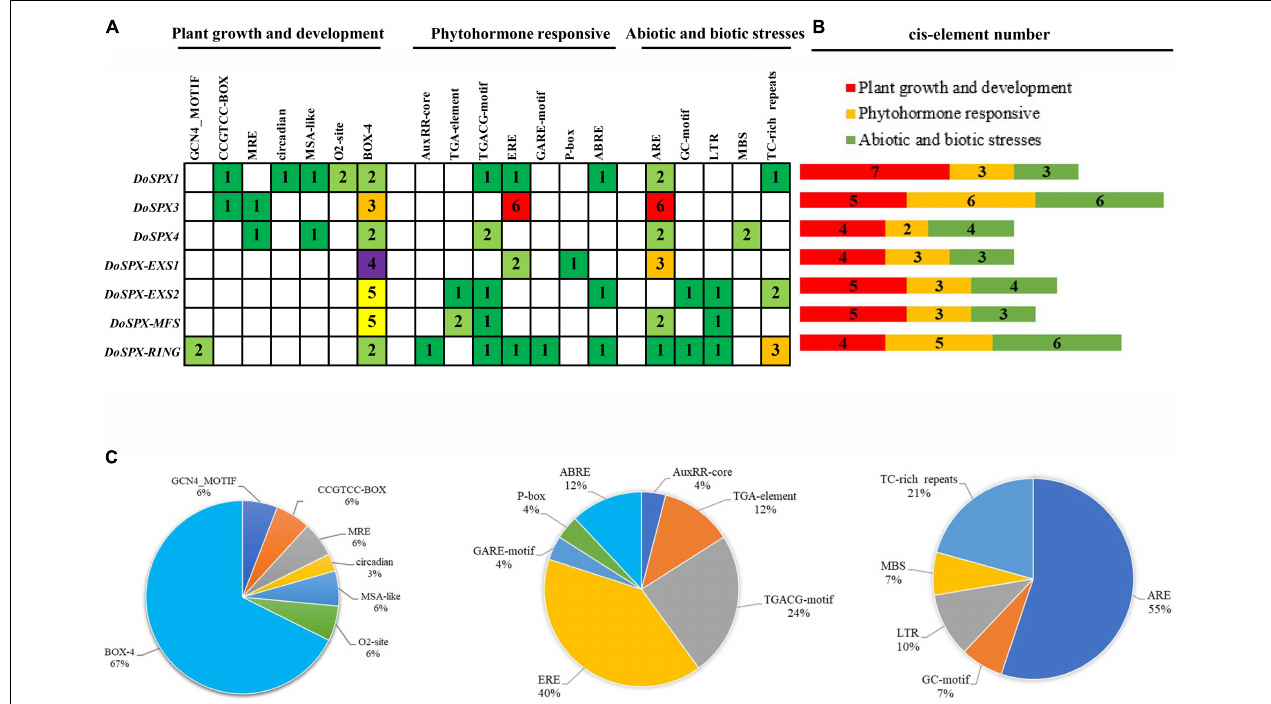
FIGURE 2 | Analysis of the cis -acting elements in DoSPXs of D. officinale . (A) The number in each cell represents the number of cis -acting elements in different SPX genes. (B) Each bar diagram represents a different type of cis -acting element. (C) The pie chart represents the proportion of promoters in other groups.